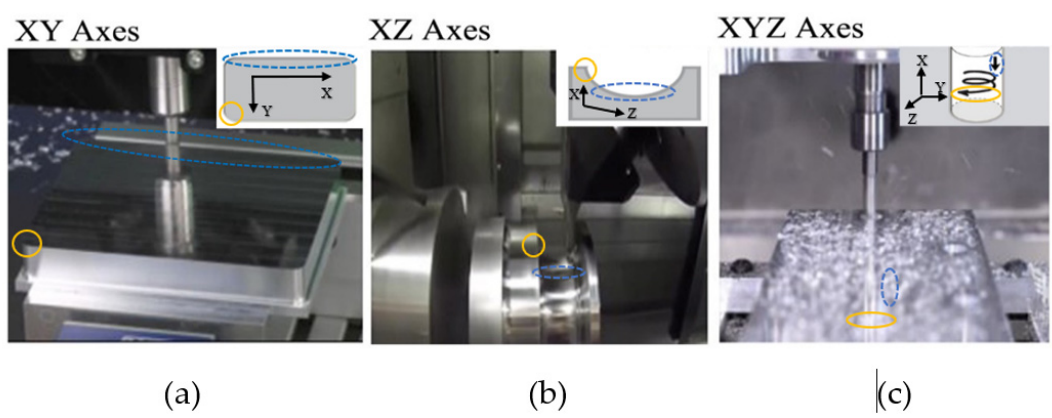
Figure 6. Operation Shapes of ( a ). XY axes [31]. Accessed on 2019, December 10. ( b ) XZ axes. Accessed on 2019, December 10. ( c ) XYZ Axes [32] Accessed on 2019, August 5.